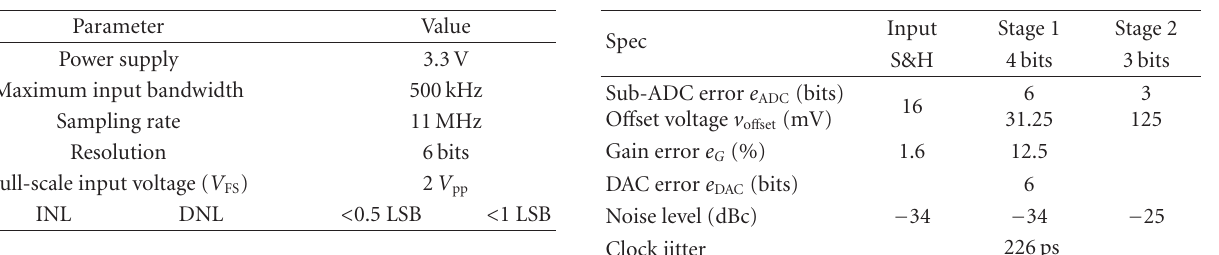
Table 2: Some design specifications for the ADC. Table 3: Specifications for pipeline ADC